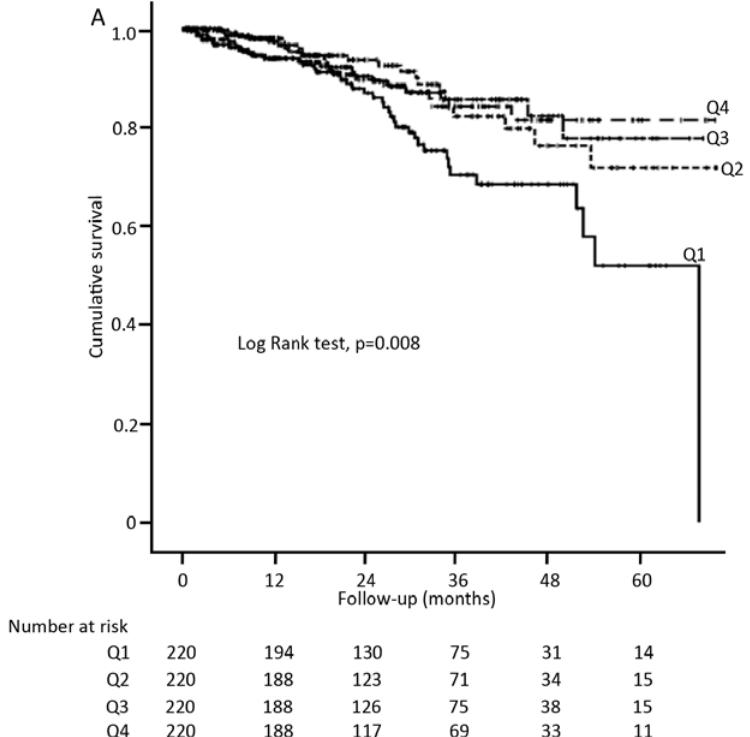
Figure 2. Cont . Figure 2.